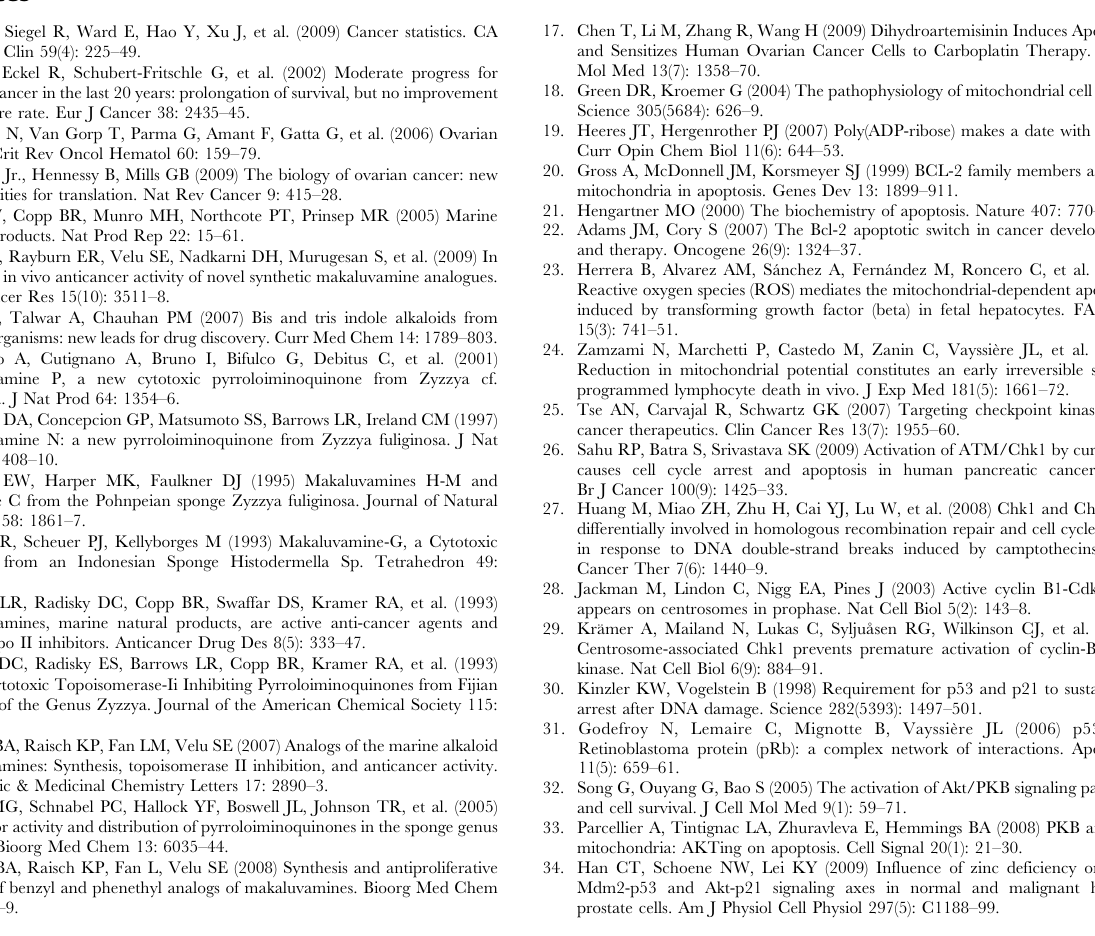
Table S3 The interaction net of significant